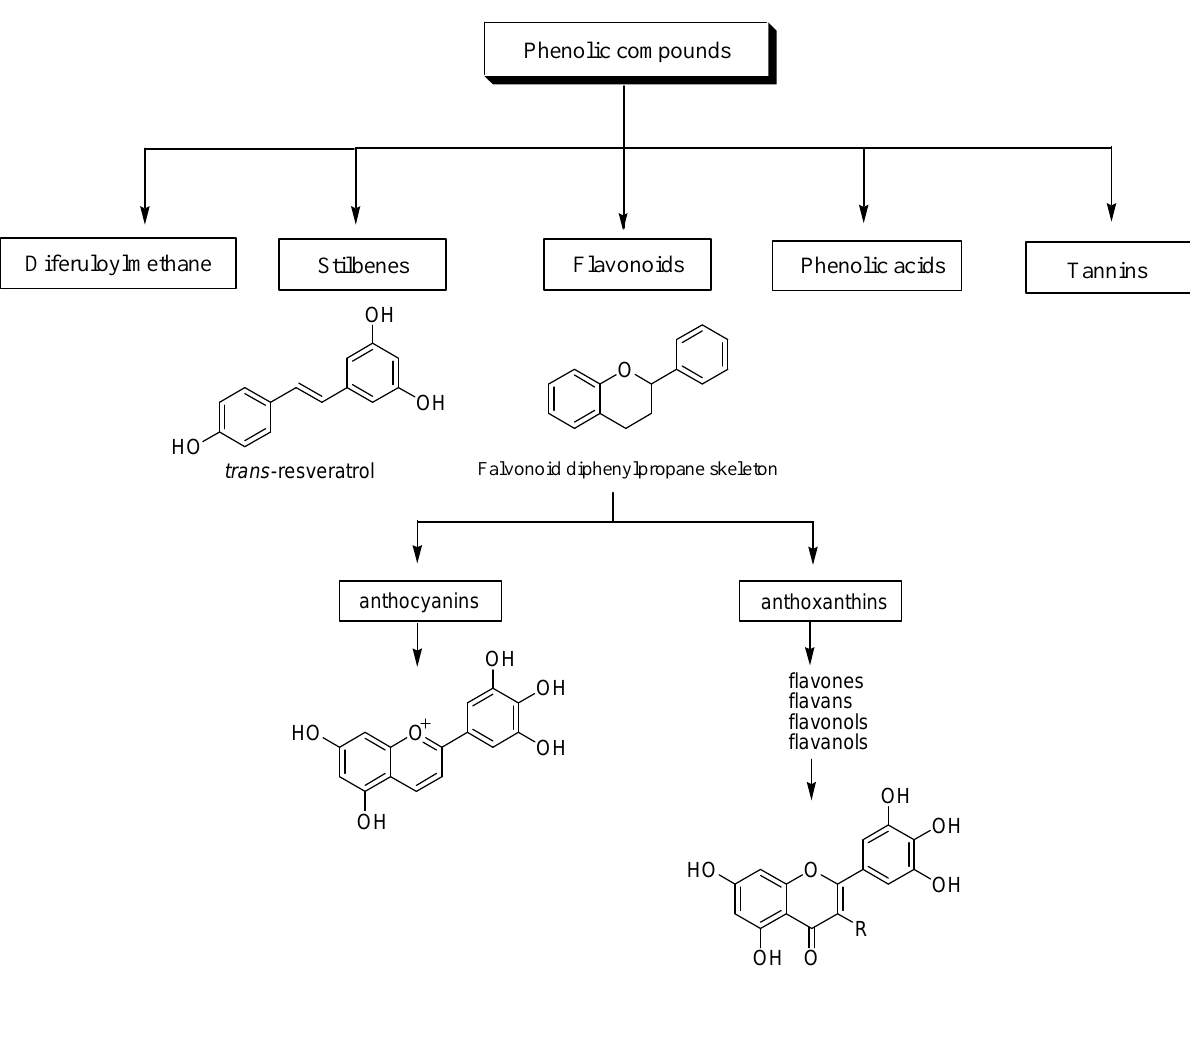
Figure 1. Classification of dietary